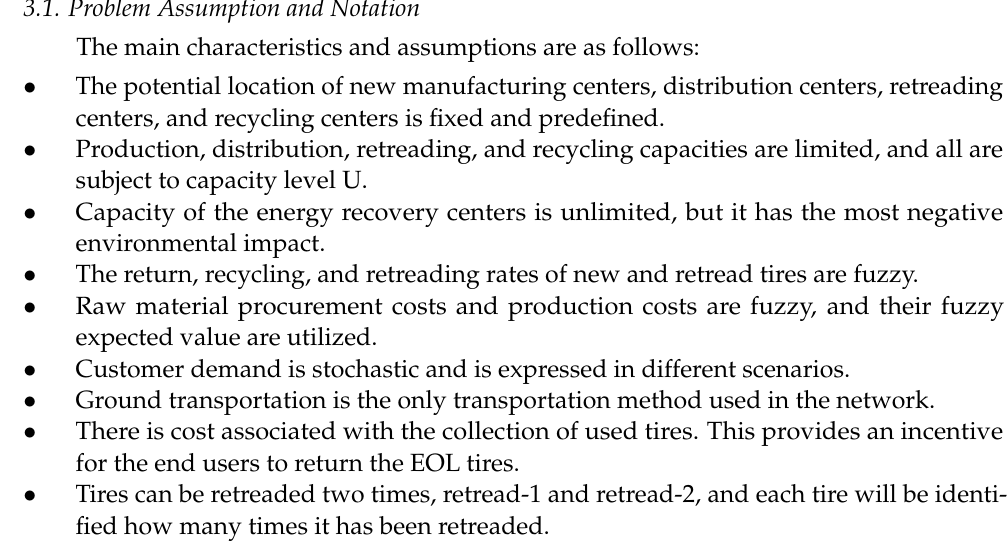
Figure 2. Schematic view of the proposed